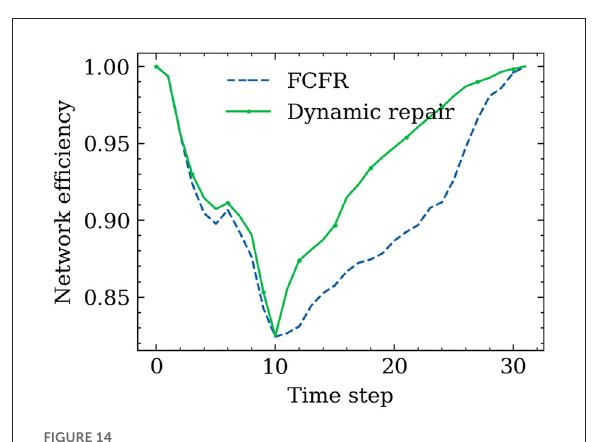
FIGURE14 Trajectory-based recovery